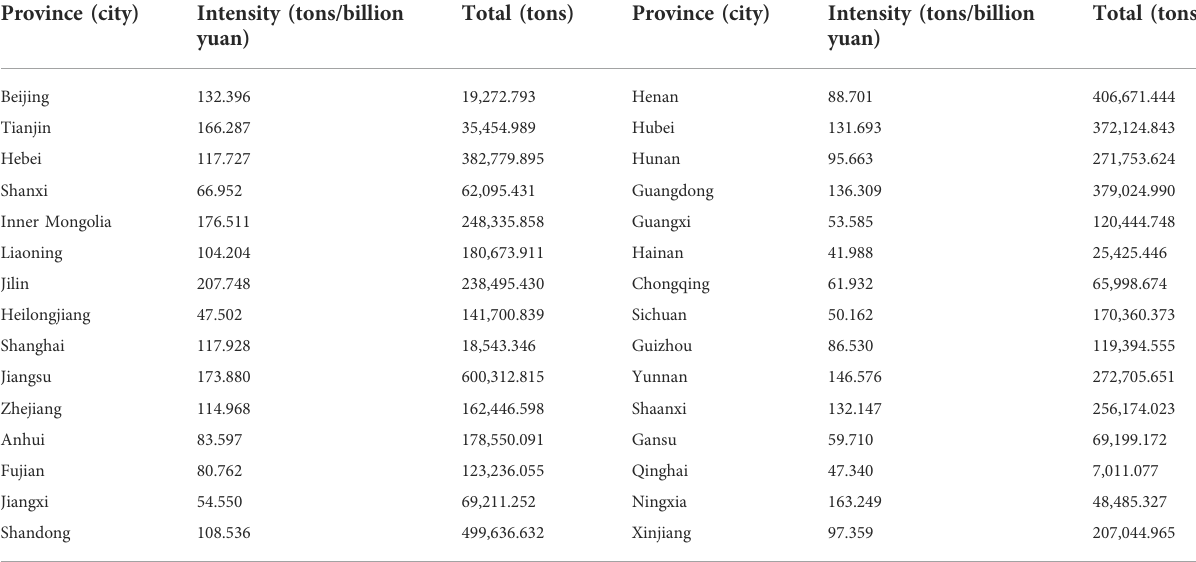
TABLE 2 Results of agricultural non-point source pollution emissions by province (city) in China from 2011 to 2020.